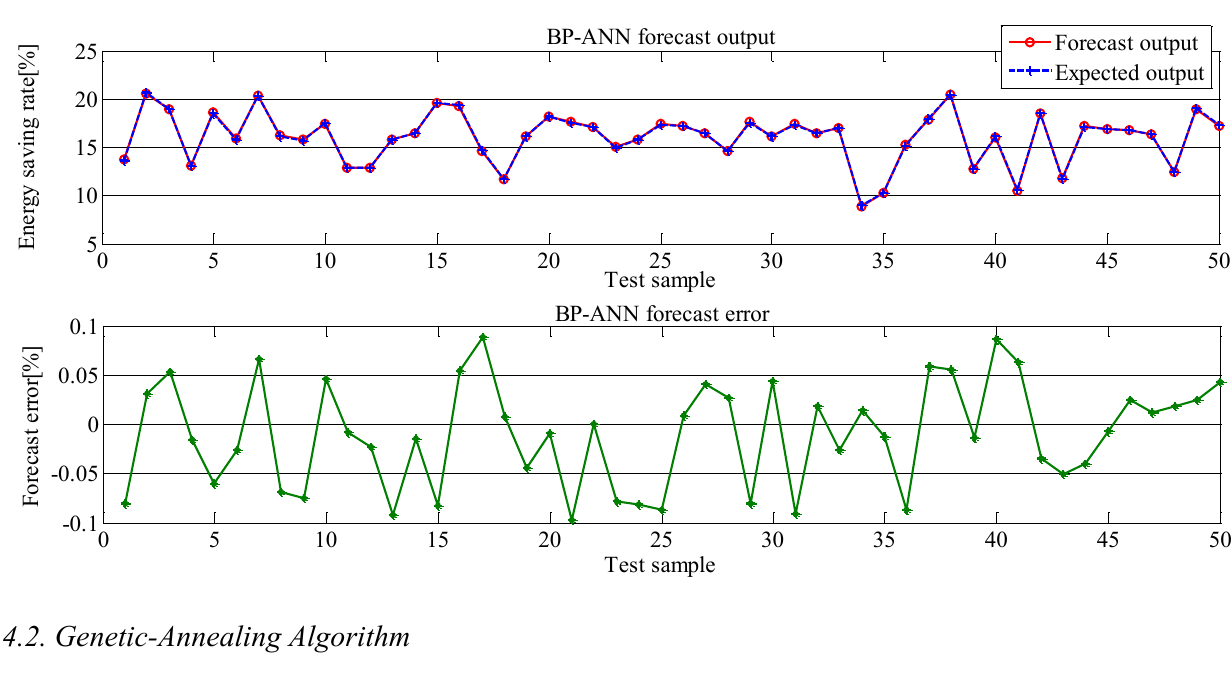
Figure 17. BP-ANN expected outputs and